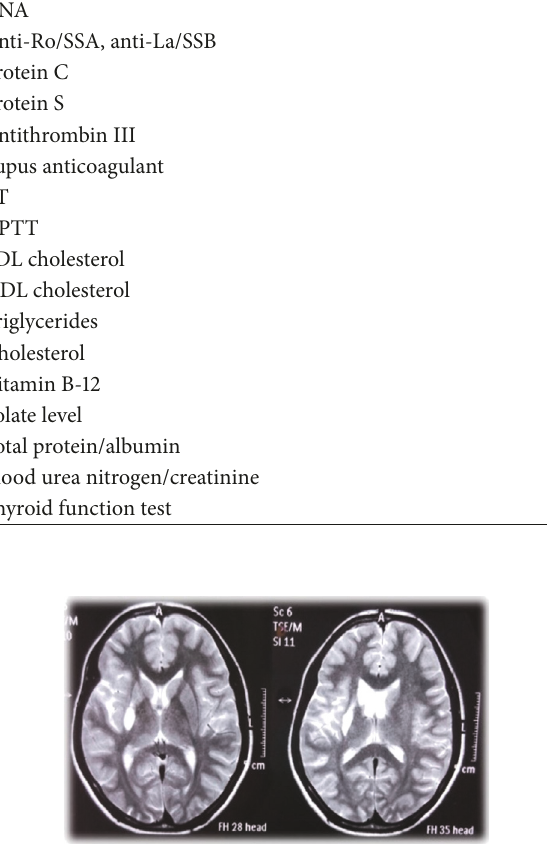
Figure 3: Cerebral angiogram (oblique view) image showing typical “puff of smoke” collaterals with right MCA stenosis (black arrow).